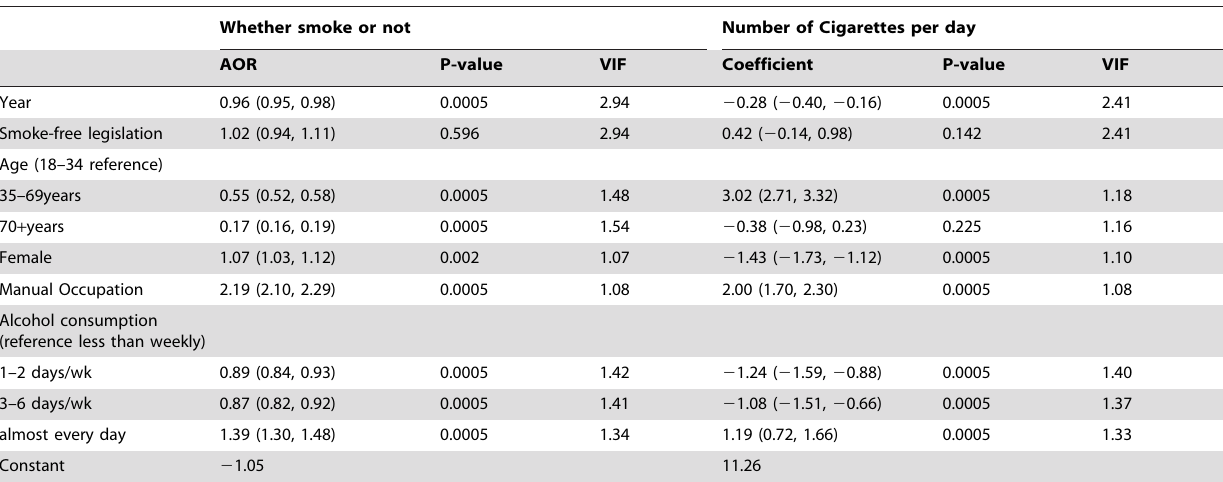
Table 1. Impact of legislation on smoking status.